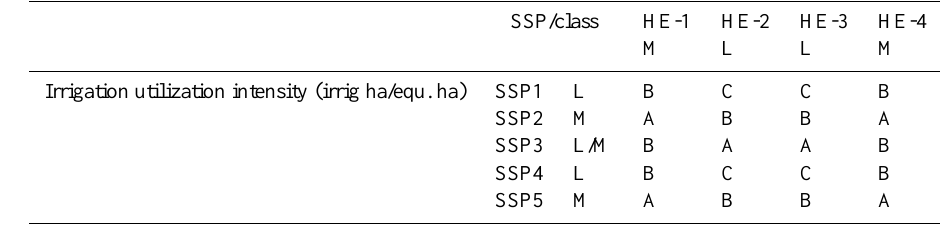
Table A10. Water dimension – irrigation utilization intensity rating.